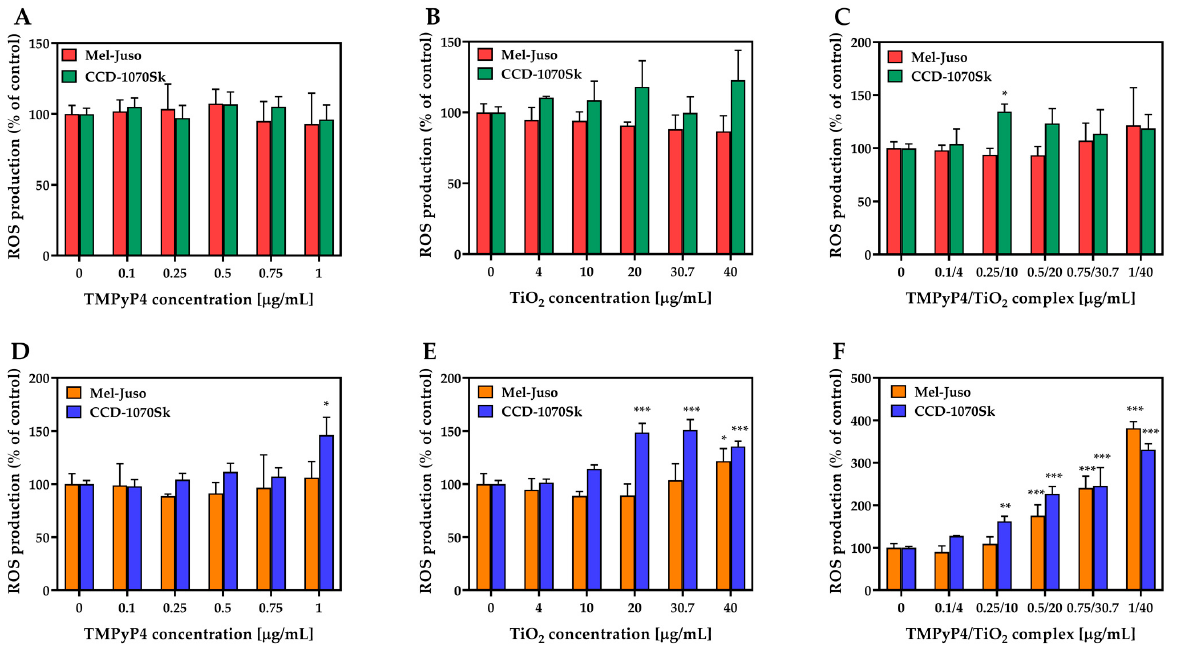
Figure 9. Effect of TMPyP4, TiO 2 NPs, and TMPyP4/TiO 2 complex on intracellular reactive oxygen species (ROS) production. The graphs present the relative level of dichlorofluorescein (DCF) fluorescence detected in treated human Mel-Juso and CCD-1070Sk cells under dark ( A – C ) and light- irradiation conditions ( D – F ). Untreated cells (0 µg/mL) were used as a control. Results (control vs. sample) were significant at p < 0.05 (*), p < 0.01 (**), and p < 0.001 (***). Error bars reflect the standard deviation.